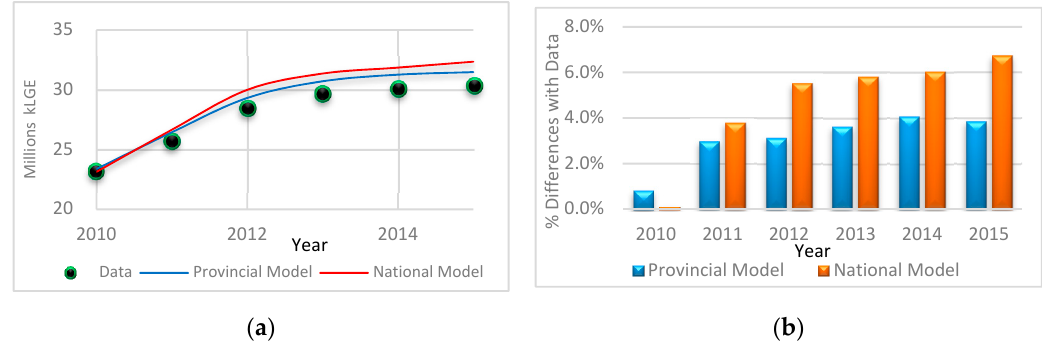
Figure 9. Comparison of energy consumption between data with model results. ( a ) Energy consumption; ( b ) Percentage.